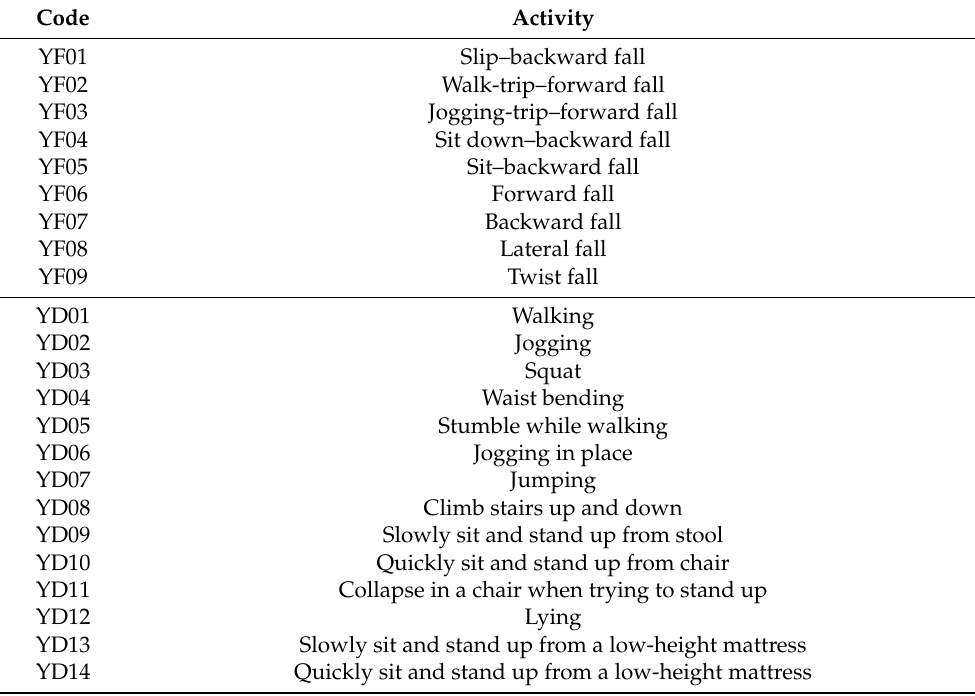
Table 1. Fall motions and ADLs used in the study.